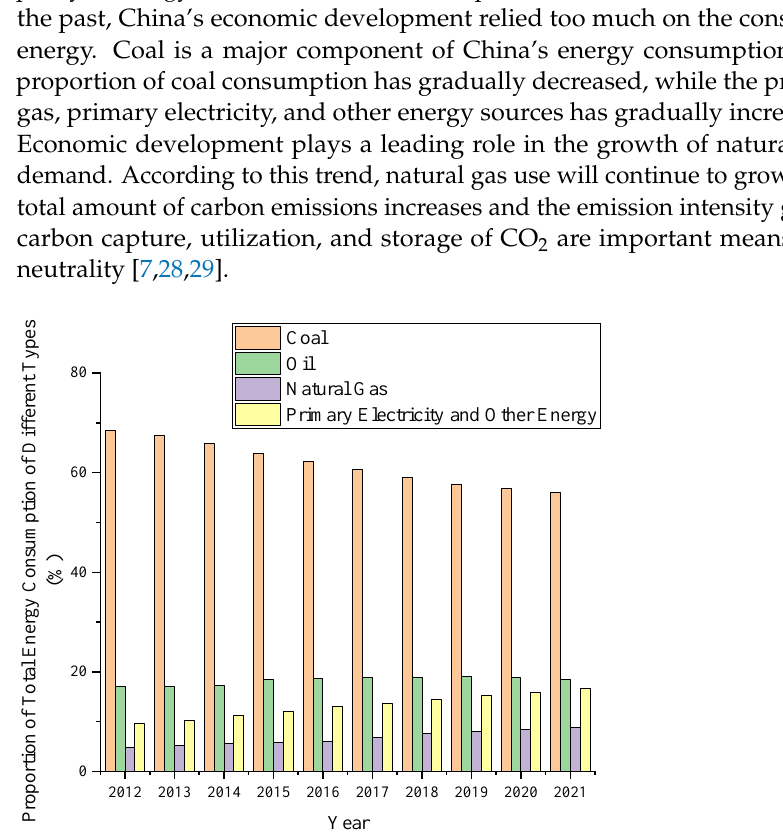
Figure 3. The proportion of total energy consumption of different types.